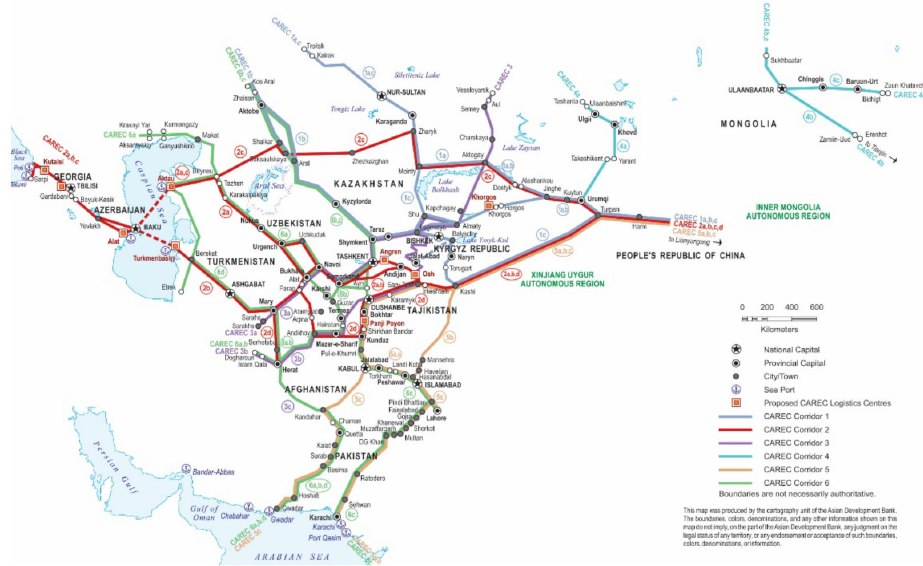
Figure 7. CAREC multimodal corridors (1. Europe–East Asia; 2. Europe–Mediterranean–East Asia; 3. Russian Federation–Middle East and South Asia; 4. Russian Federation–East Asia; 5. East Asia–Middle East and South Asia; 6. Europe, Middle East, and South Asia)